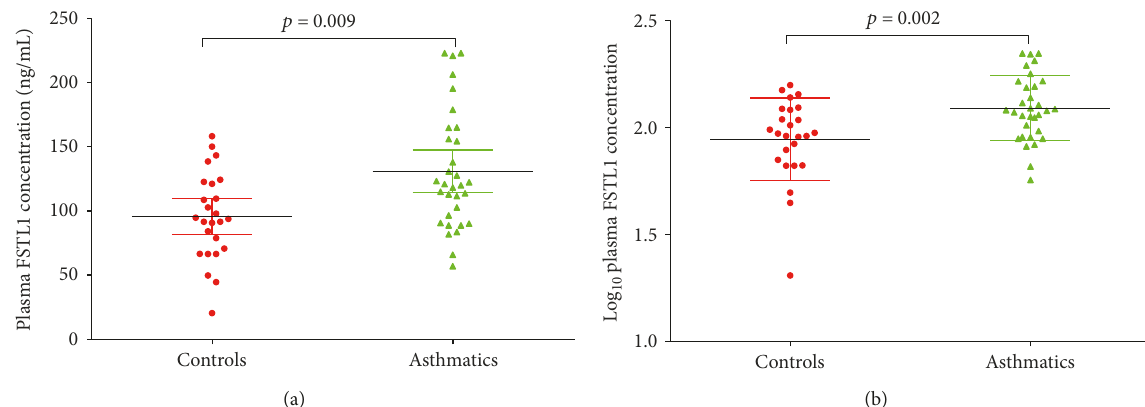
FSTL1 levels in 10